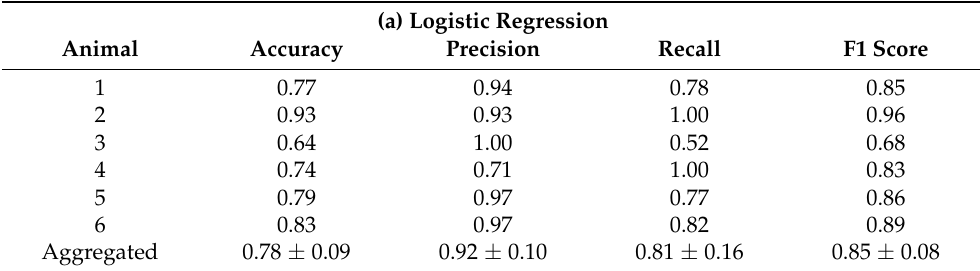
Table 1. Performance of 1st-stage classifier based on leave-one-subject-out analysis. Aggregated performance is shown in terms of mean and standard